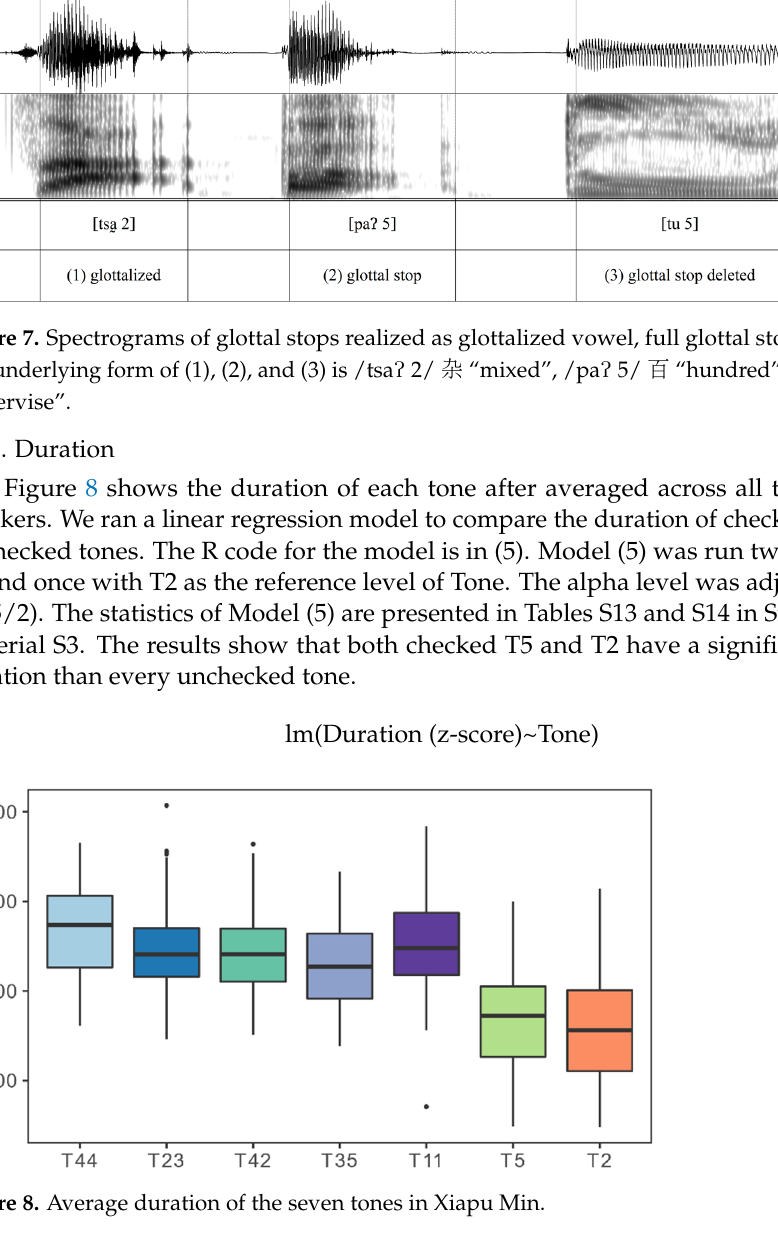
Figure 8. Average duration of the seven tones in Xiapu Min.